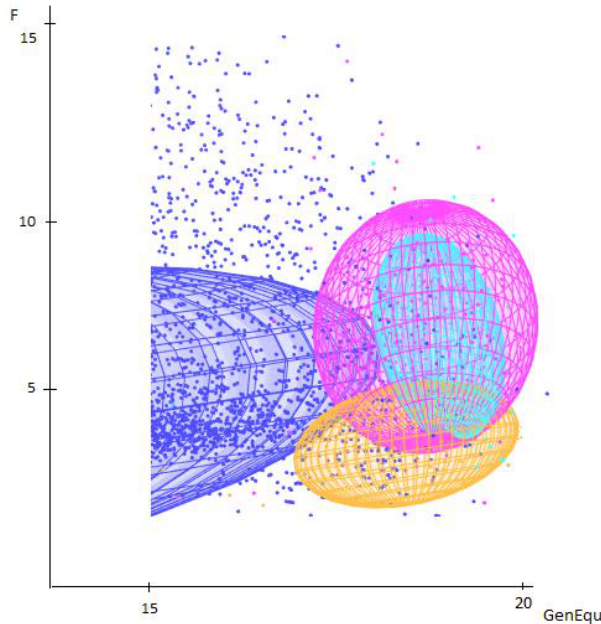
Figure 3. The inbreeding coe ffi cients of the di ff erent lines depending on the total generation equivalent, where F is the inbreeding coe ffi cient of an individual and GenEqu is the number of complete generation equivalents. Show line, Show line, Total Figure 3. The inbreeding coefficients of the different lines depending on the total generation equivalent, Figure 3. The inbreeding coefficients of the different lines depending on the total generation equivalent, Figure 3. The inbreeding coefficients of the different lines depending on the total generation equivalent, Figure 3. The inbreeding coefficients of the different lines depending on the total generation equivalent, Figure 3. The inbreeding coefficients of the different lines depending on the total generation equivalent, where F is the inbreeding coefficient of an individual and GenEqu is the number of complete generation where F is the inbreeding coefficient of an individual and GenEqu is the number of complete generation where F is the inbreeding coefficient of an individual and GenEqu is the number of complete generation where F is the inbreeding coefficient of an individual and GenEqu is the number of complete generation where F is the inbreeding coefficient of an individual and GenEqu is the number of complete generation equivalents. equivalents. equivalents. equivalents. equivalents.